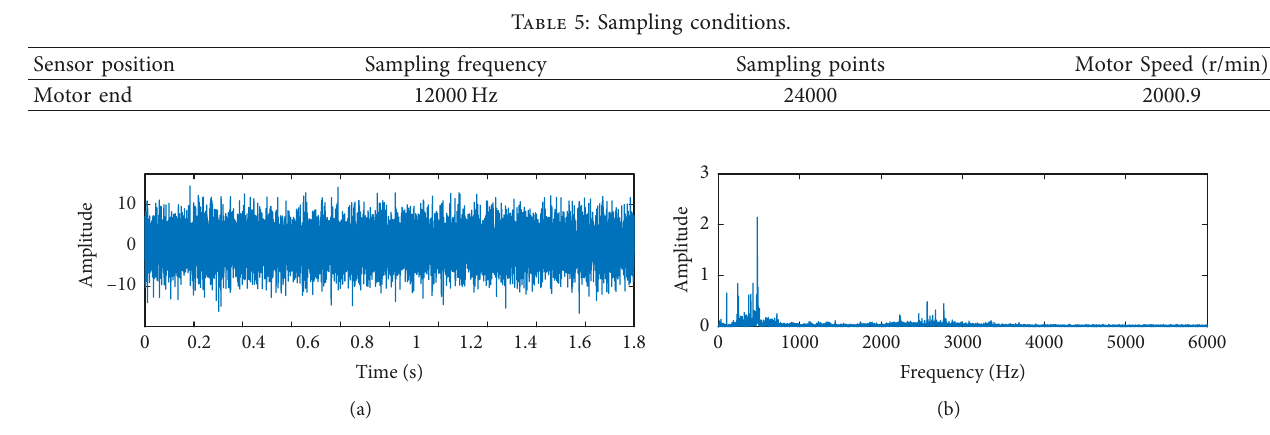
Figure 15: (a) Original signal; (b) frequency spectrum.